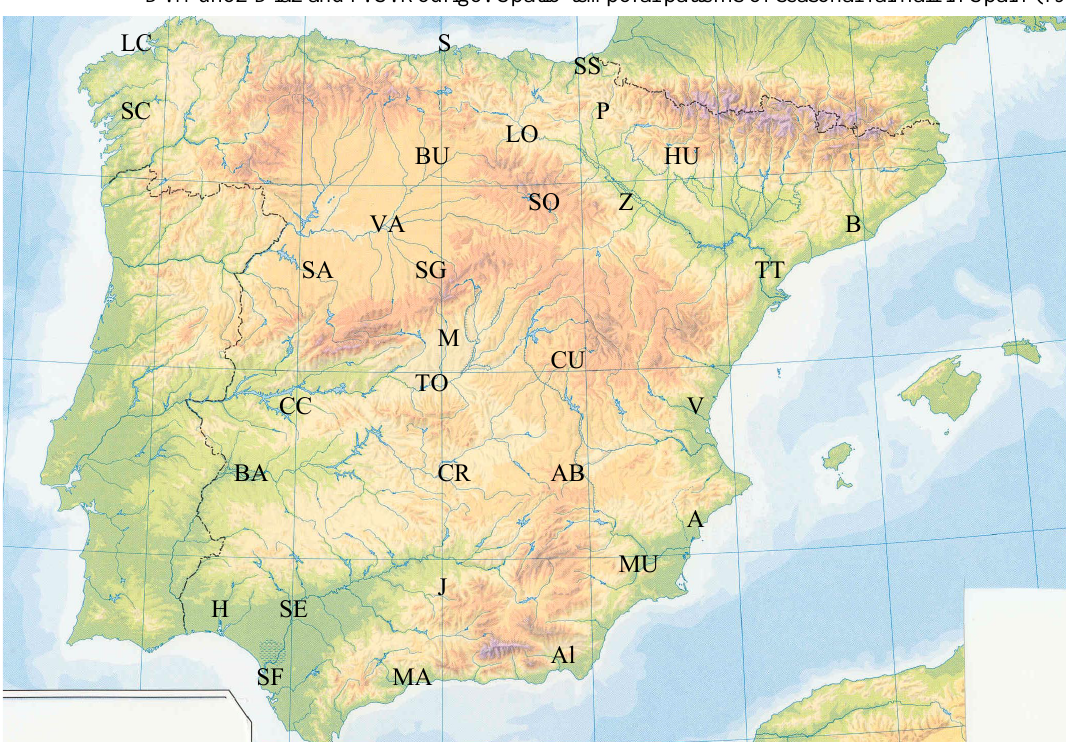
Fig. 1. Map of the study area (station code in Table